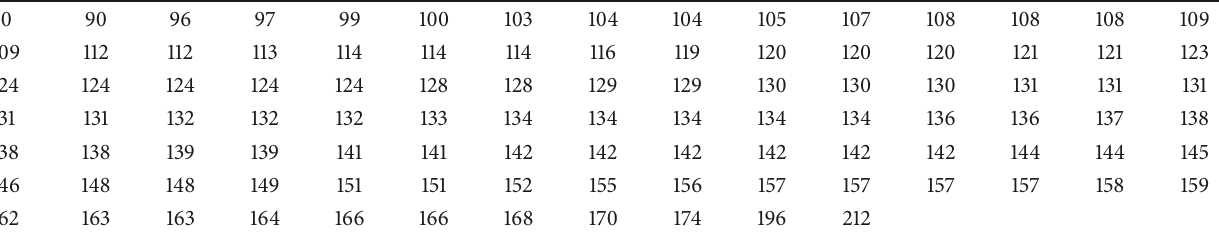
Table 2: Fatigue time of 101 6061-T6 aluminum coupons.